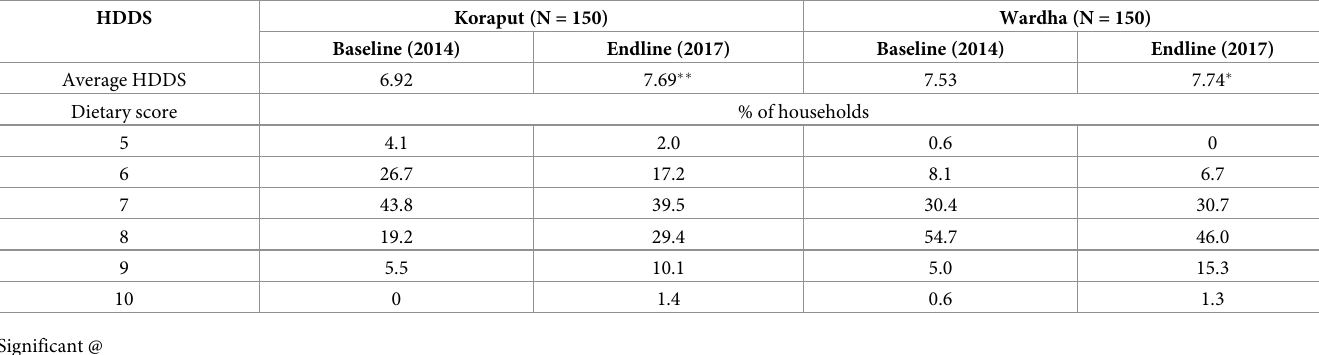
Table 8. Percentage of households based on household dietary diversity